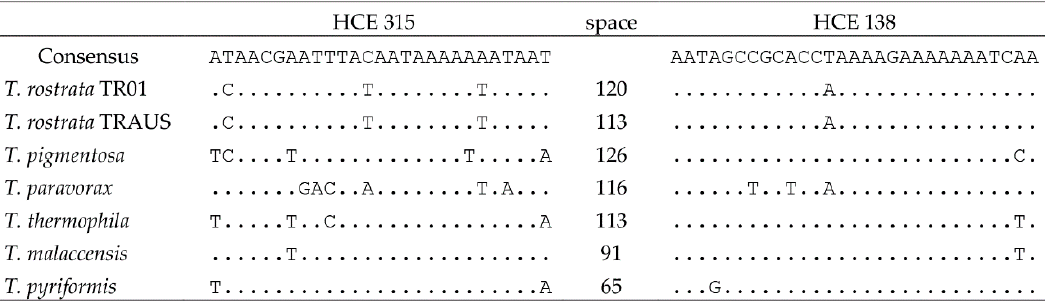
Table 3. Comparison of HCE sequences in between ymf77 and cob in Tetrahymena species.